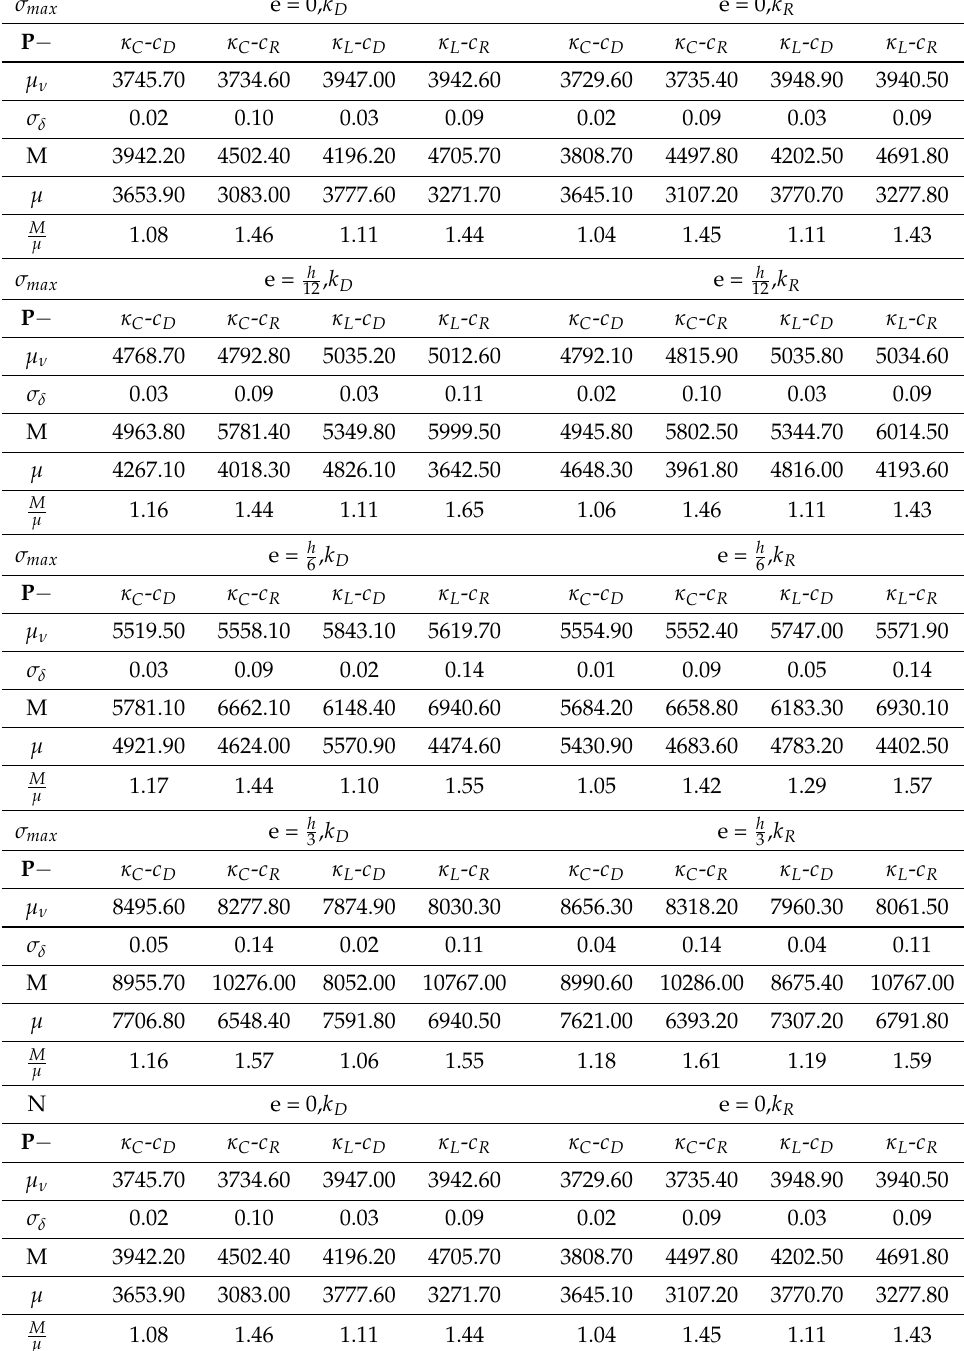
Table A2. Monte Carlo results for the maximum stress kPa the normal force kN the maximum and minimum displacements m and the rotation of the foundation rad for porous analyses with deterministic shape functions for the stochastic material variables. µ ν , σ δ , M, µ stand for the mean value, the coefficient of variation, the maximum and the minimum value of the output random vector. σ max , N, u max , u min , φ denote the maximum footing settlement stress, the foundation axial force at failure, the maximum failure displacement, the minimum failure displacement and the corresponding rotation of the shallow foundation